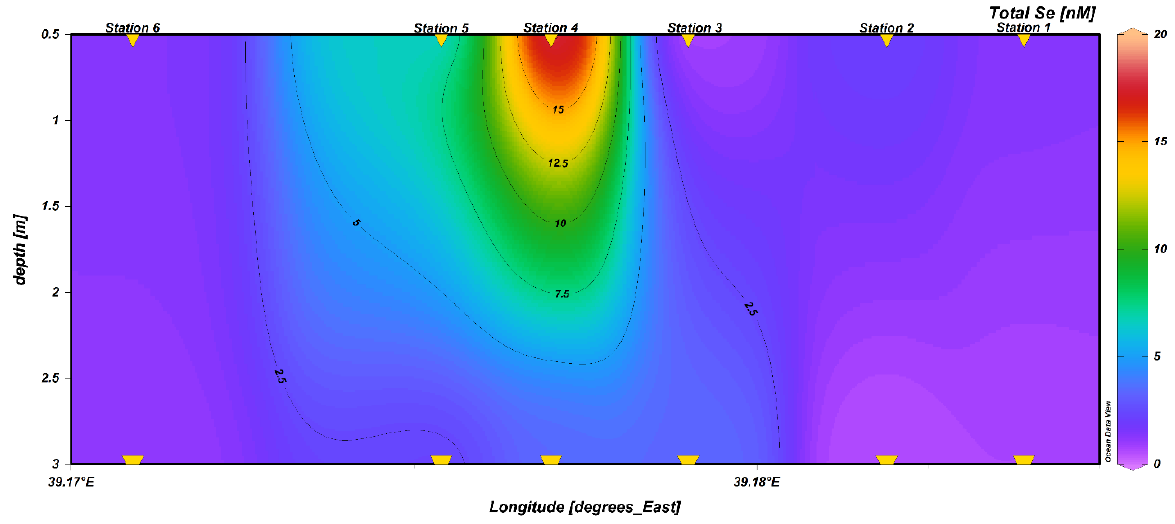
Figure 4. TDSe vertical cross-section along Al-Arbaeen